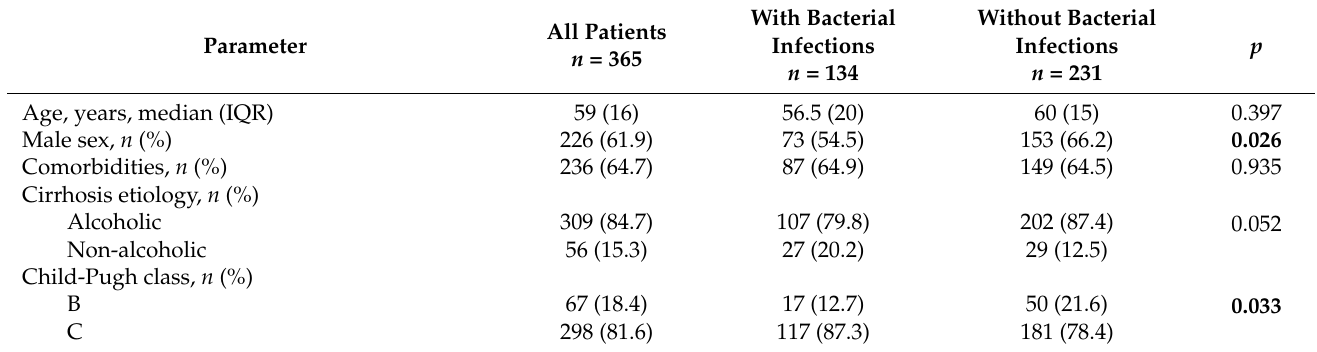
Table 1. Clinical and laboratory characteristics of the study